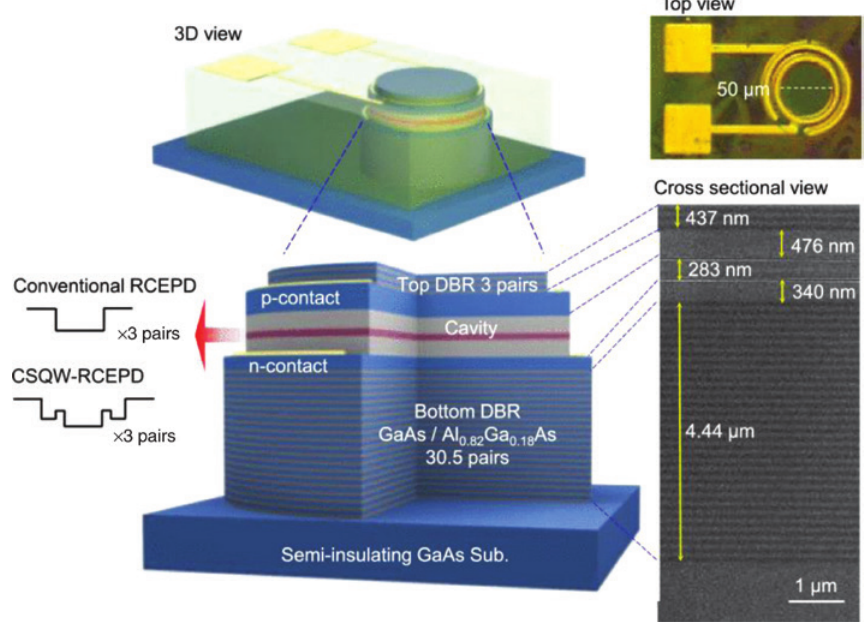
Figure 11: 3D schematic illustration, top view microscope image and cross-sectional scanning electron microscope image of the fabricated RCEPDs